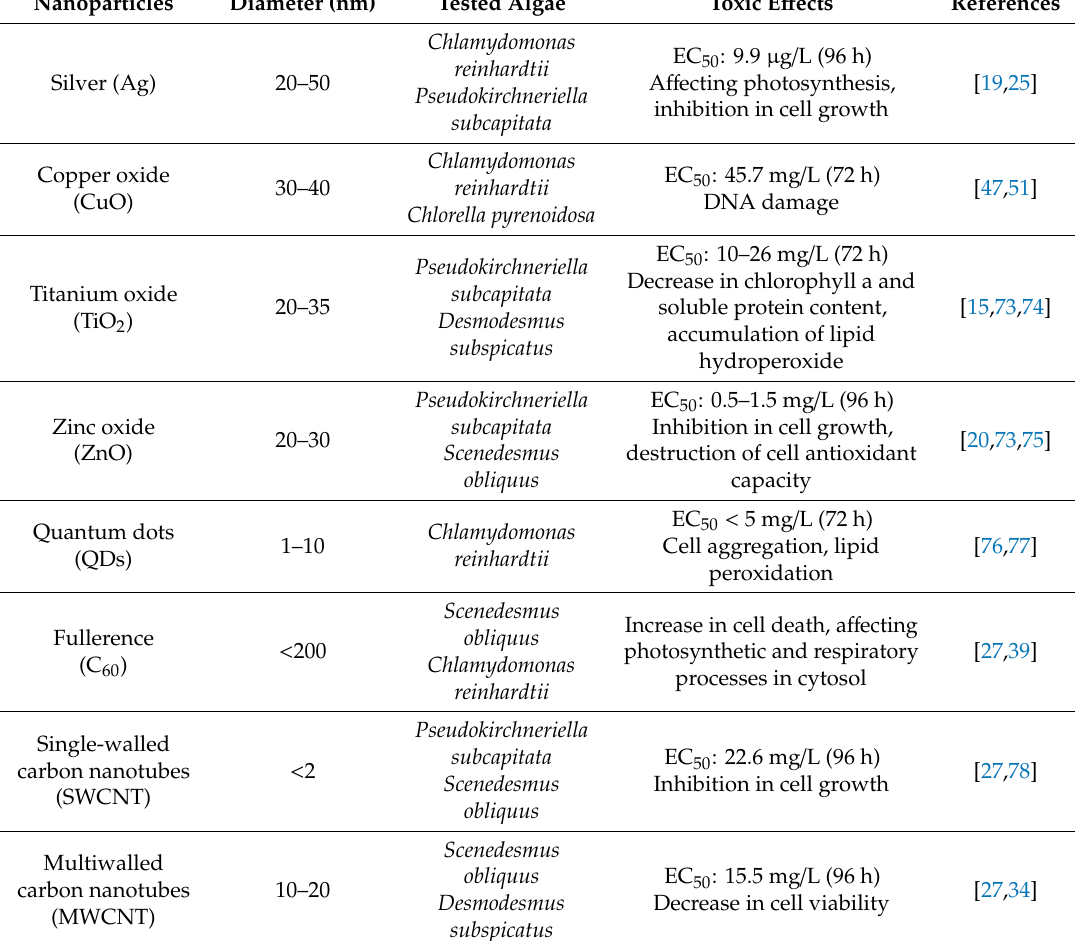
Table 2. Toxic e ff ects of nanoparticles on